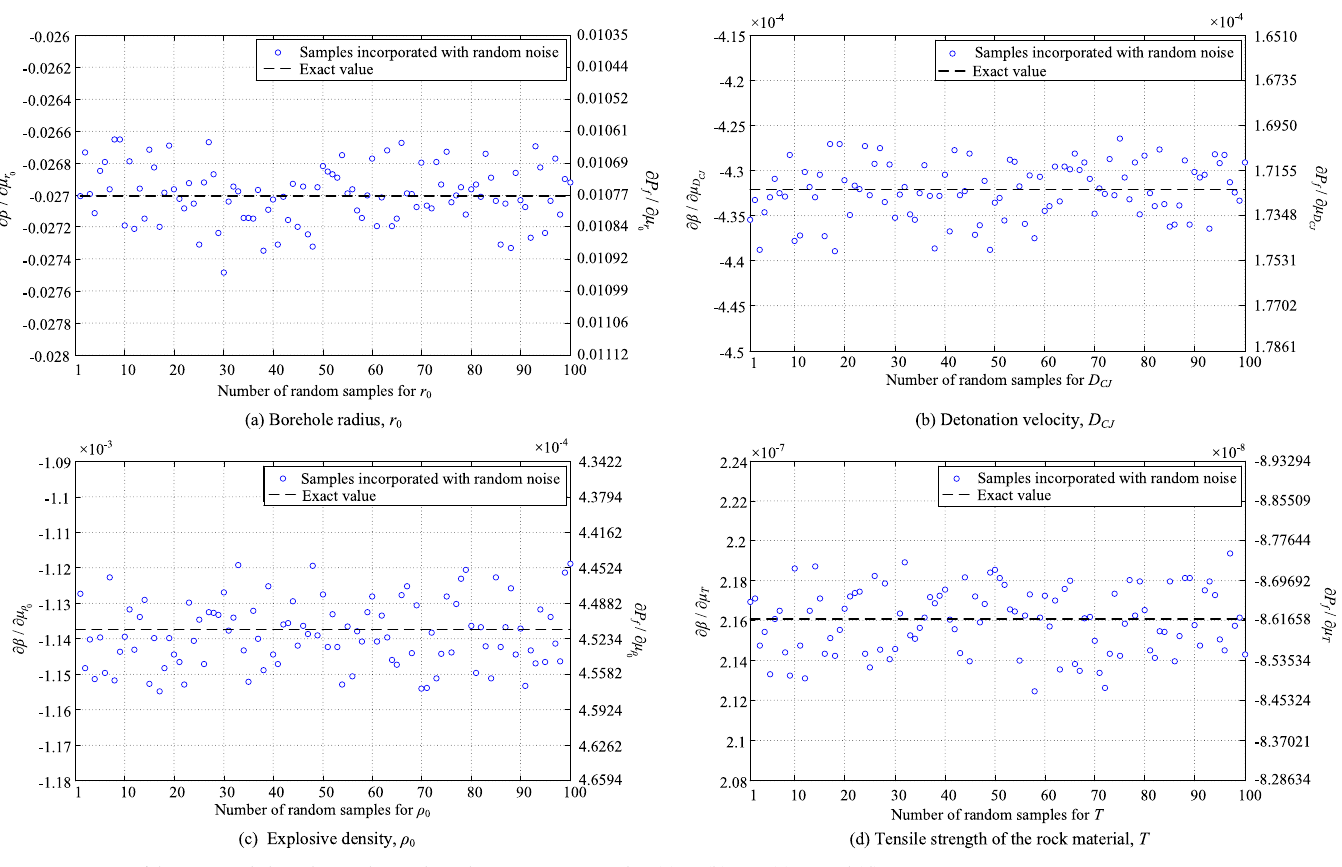
Fig 7. Response of the proposed algorithm to the random changes incorporated in (a) r 0 , (b) D